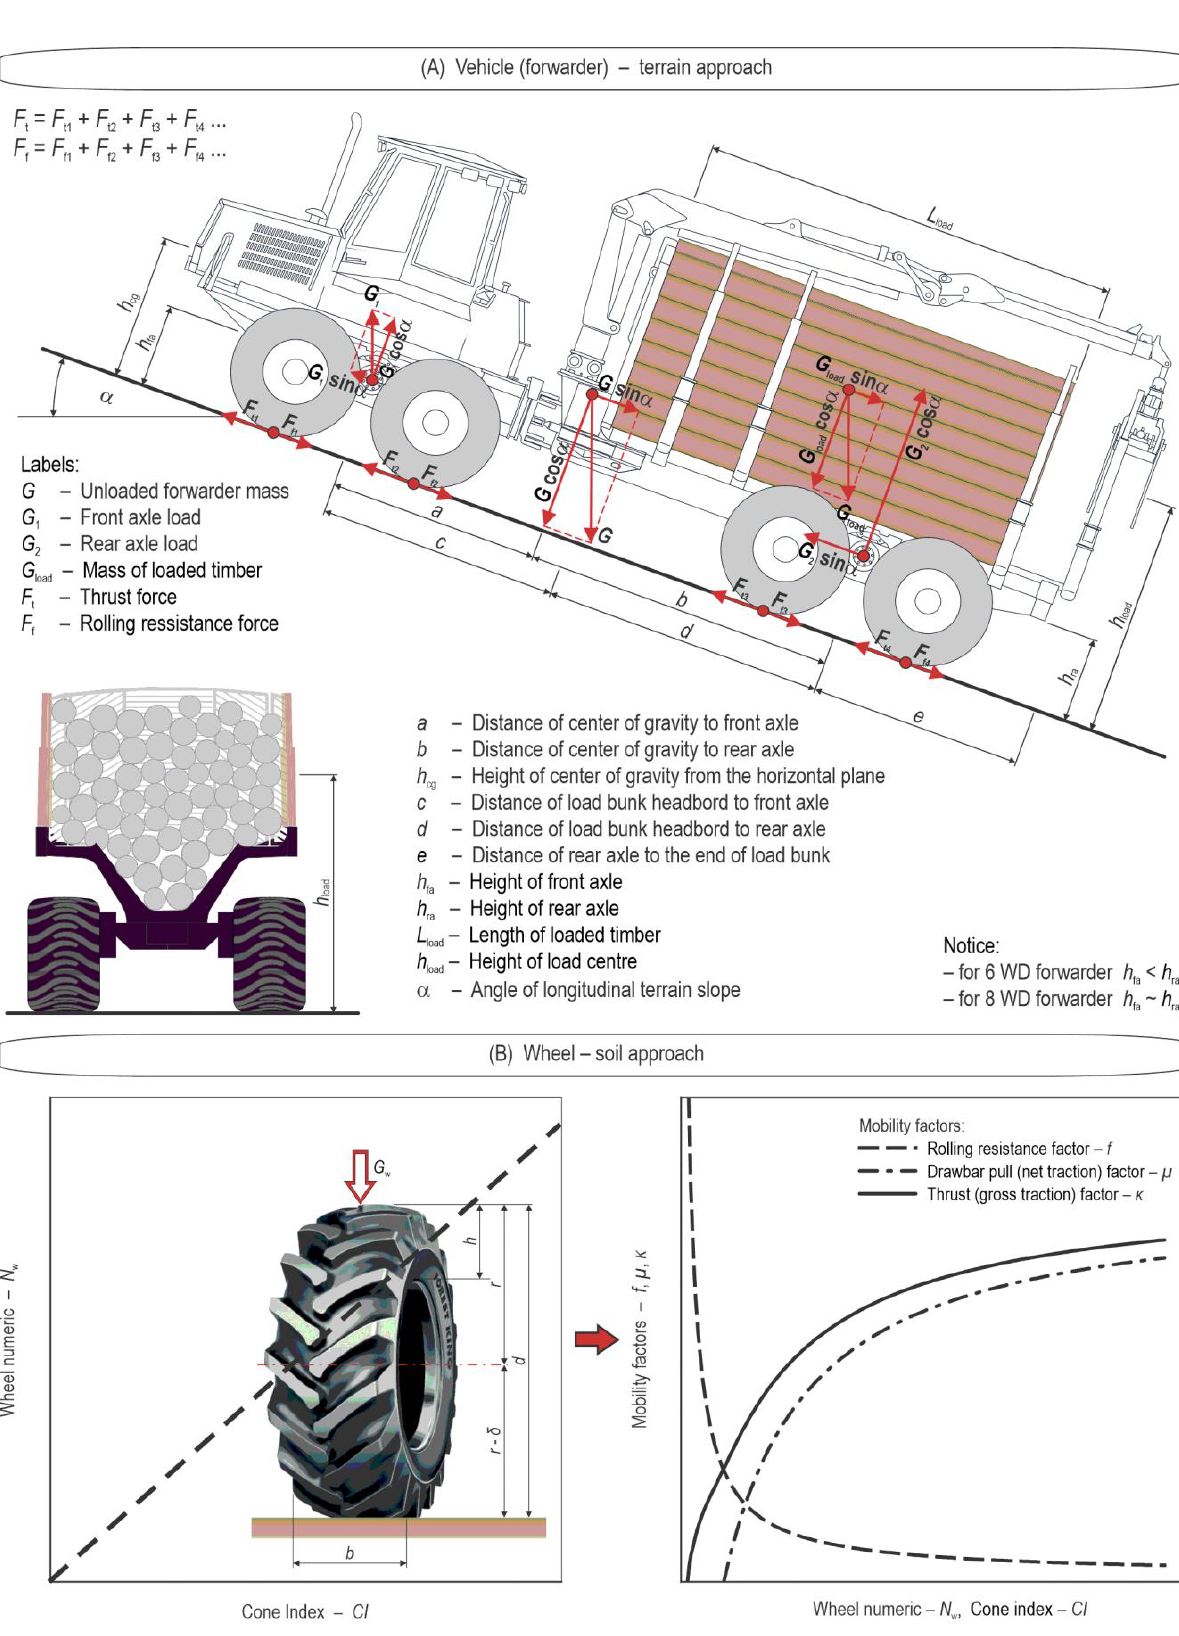
Figure 1. Research approaches to forwarder mobility: ( A ) vehicle – terrain approach and ( B ) wheel – soil approach .